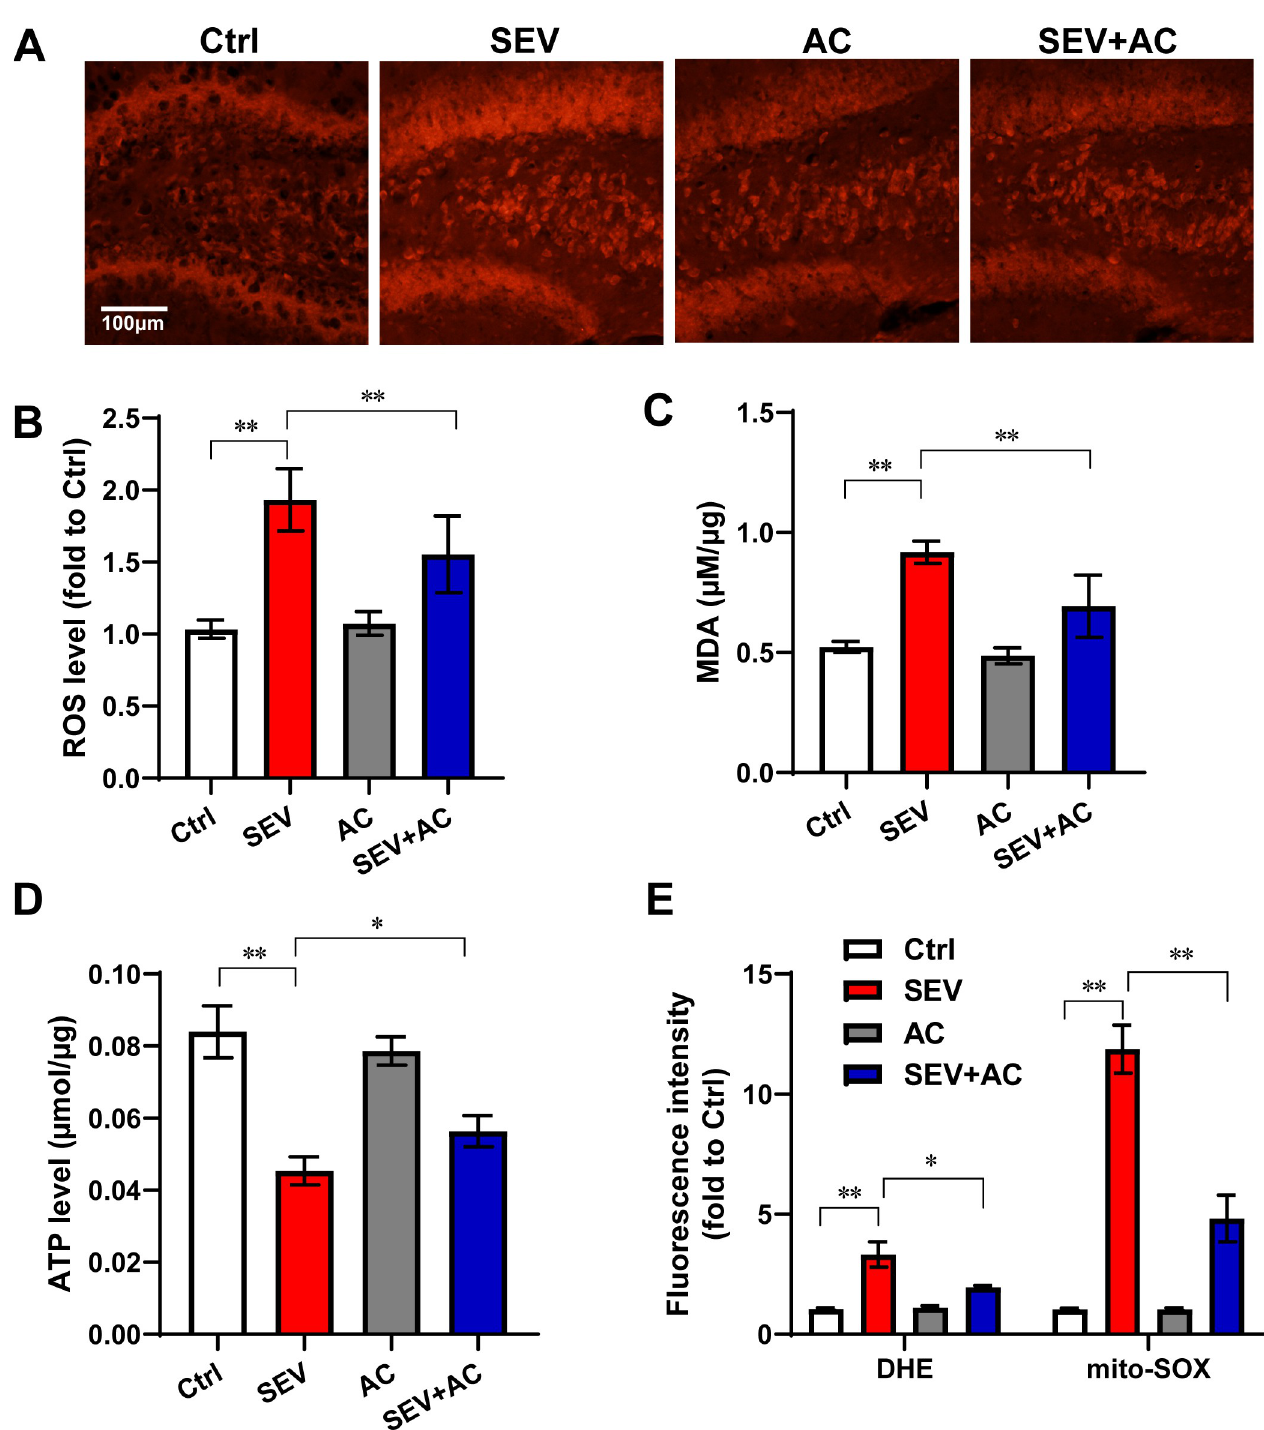
Fig 4. Ac-YVAD-cmk mitigated mitochondria dysfunction induced by sevoflurane. Eighteen-month-old mice were subjected to 2% sevoflurane for 5 h. Ac-YVAD-cmk (12.5 μ mol/kg) was administrated intraperitoneally before sevoflurane treatment. (A) DHE staining in hippocampus. Scale bar represents 100 μ m. (B) The semi-quantitative analysis for the DHE staining. n = 3. (C) The MDA assay of hippocampus. n = 4; (D) The ATP level of hippocampus. n = 4; (D) H4 cells were treated with Ac-YVAD-cmk (40 μ M) for 30 min in advance of 4.1% sevoflurane exposure for 6 h. The intracellular ROS and mitochondrial ROS levels were measured. n = 6. The data are expressed as mean ± SD. � P < 0.05, �� P < 0.01.